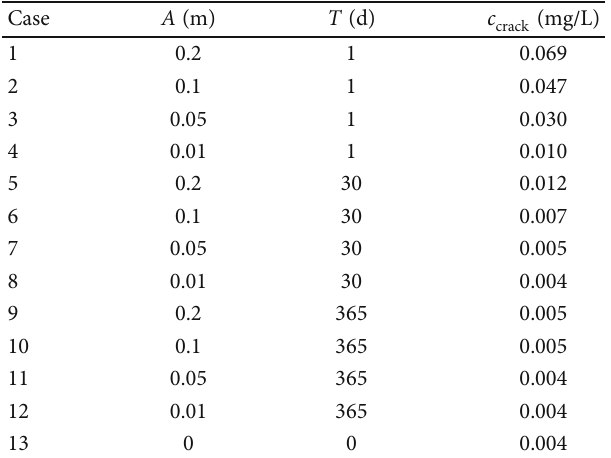
Figure 7: The variation of normalized gaseous TCE concentration at the crack for the cases with di ff erent fl uctuation amplitudes and periods: (a) T =one day, (b) T =one month, and (c) T =one year. Table 2: The gaseous TCE concentration at the crack under the dynamic equilibrium 638 conditions for cases with di ff erent combinations of amplitude and